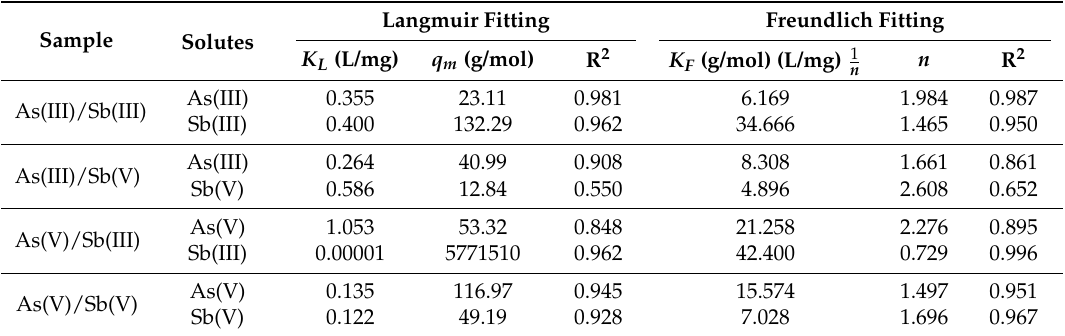
Table 2. Adsorption isotherm parameters of As and Sb species on FC precipitates in the binary system.